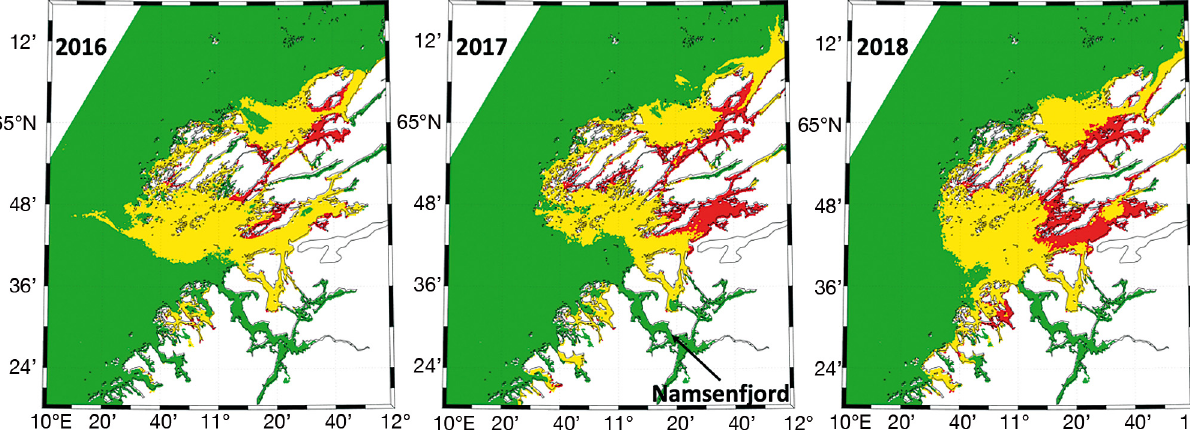
Fig. 5. Calculated areas of elevated lice infection pressure (relative operating characteristic maps) separated into high (red), moderate (yellow) and low (green) risk areas during the salmon post-smolt migration period from 20 May to 17 June for